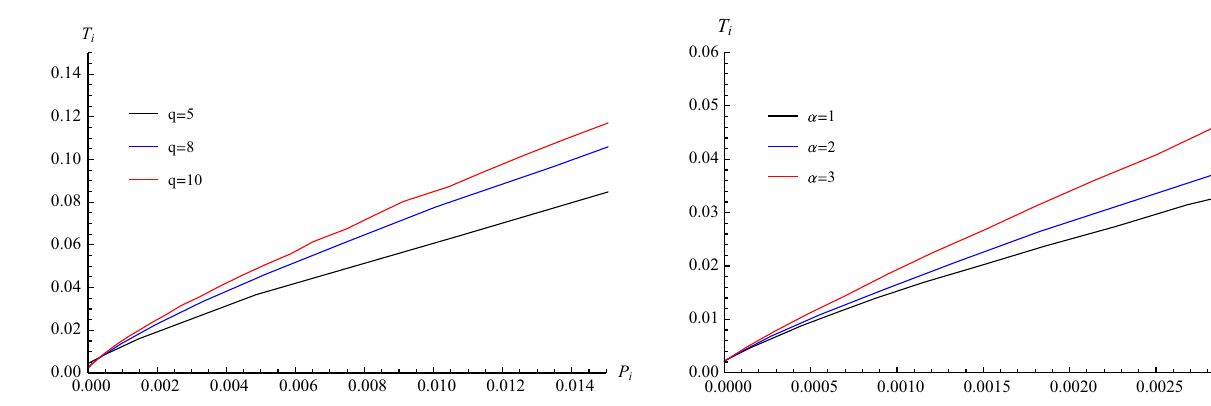
Fig. 6 Inversion curves P i − T i for heating process and cooling for different charges. We set α = 1